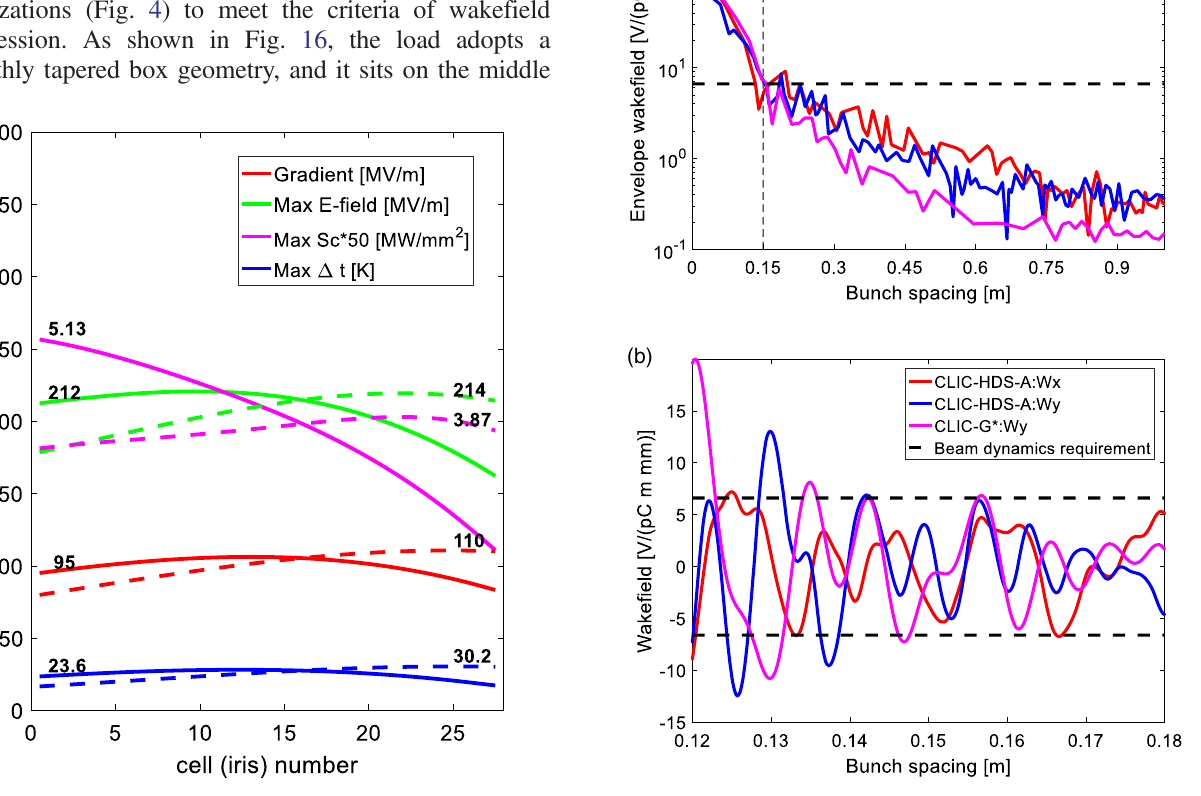
FIG. 15. Field distribution of structure cells (solid line: loaded 100 MV = m; dashed line: unloaded 100 MV =